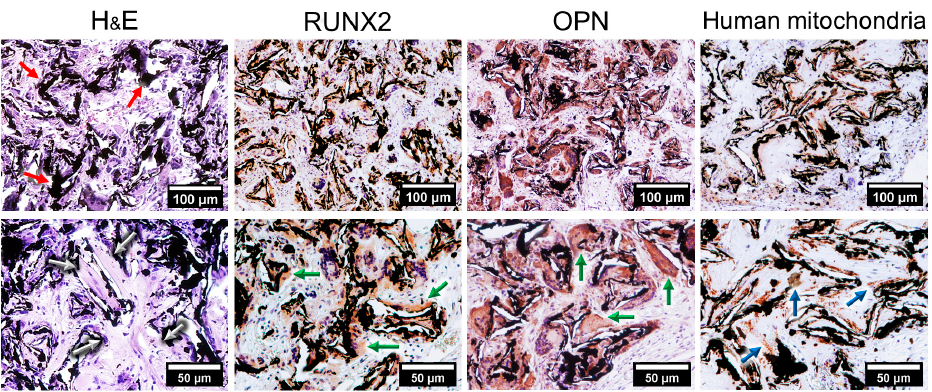
Figure 1. Graphene scaffold induce osteogenic differentiation in vivo. MSCs were seeded onto graphene scaffolds and transplanted into subcutaneous pockets of SCID mice. After four weeks, there was the formation of bony-like structures on the surface of the graphene scaffold (H&E, white arrows) that presented positive expression for the markers of osteogenic differentiation Runt-related transcription factor 2 (RUNX2) and osteopontin (OPN) (green arrows). The positive staining for specific for human mitochondria confirmed that the tissues formed were populated by human cells (blue